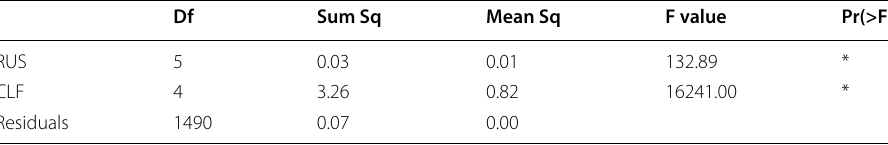
*Indicates the Pr(>F) value is less than 1 × 10 − 4